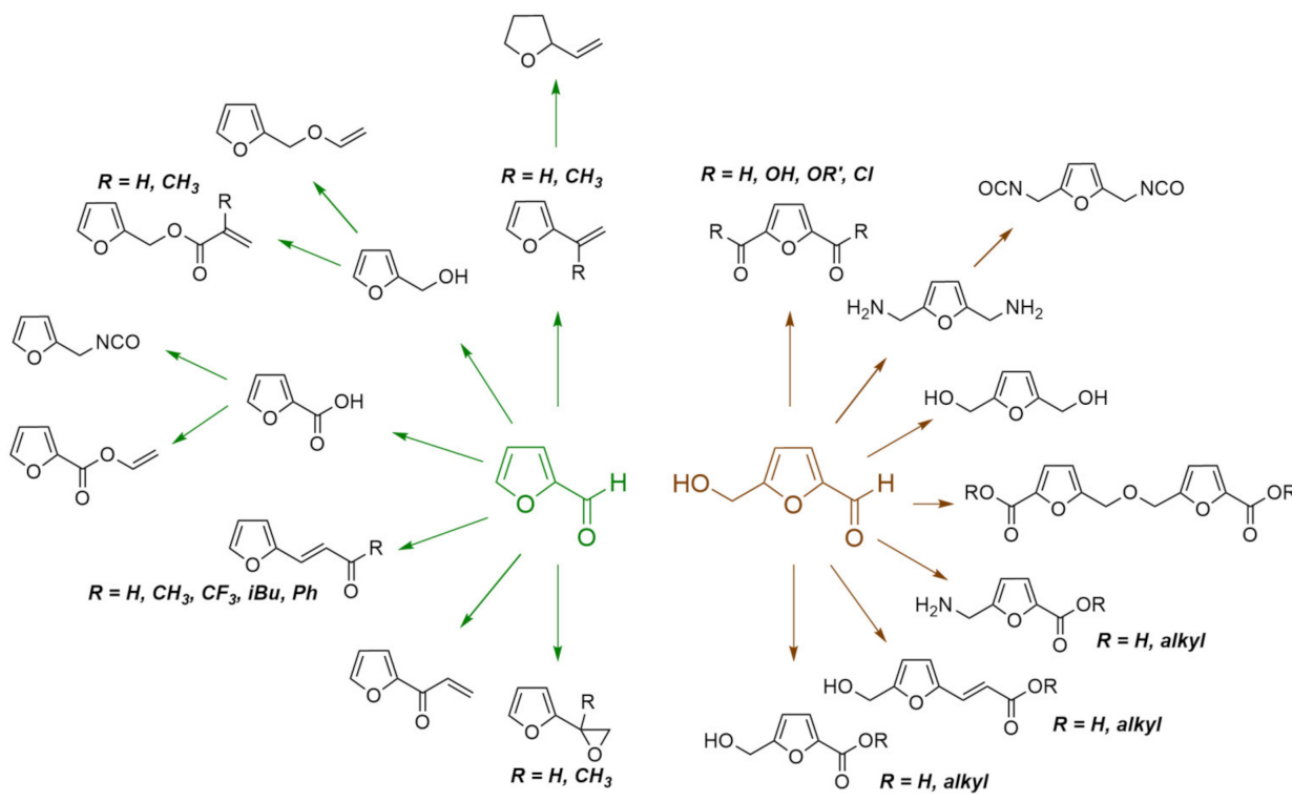
Figure 6. F (in green) and HMF (in brown) as typical precursors to some furan monomers that can be polymerized by chain-growth and step-growth reaction mechanisms,